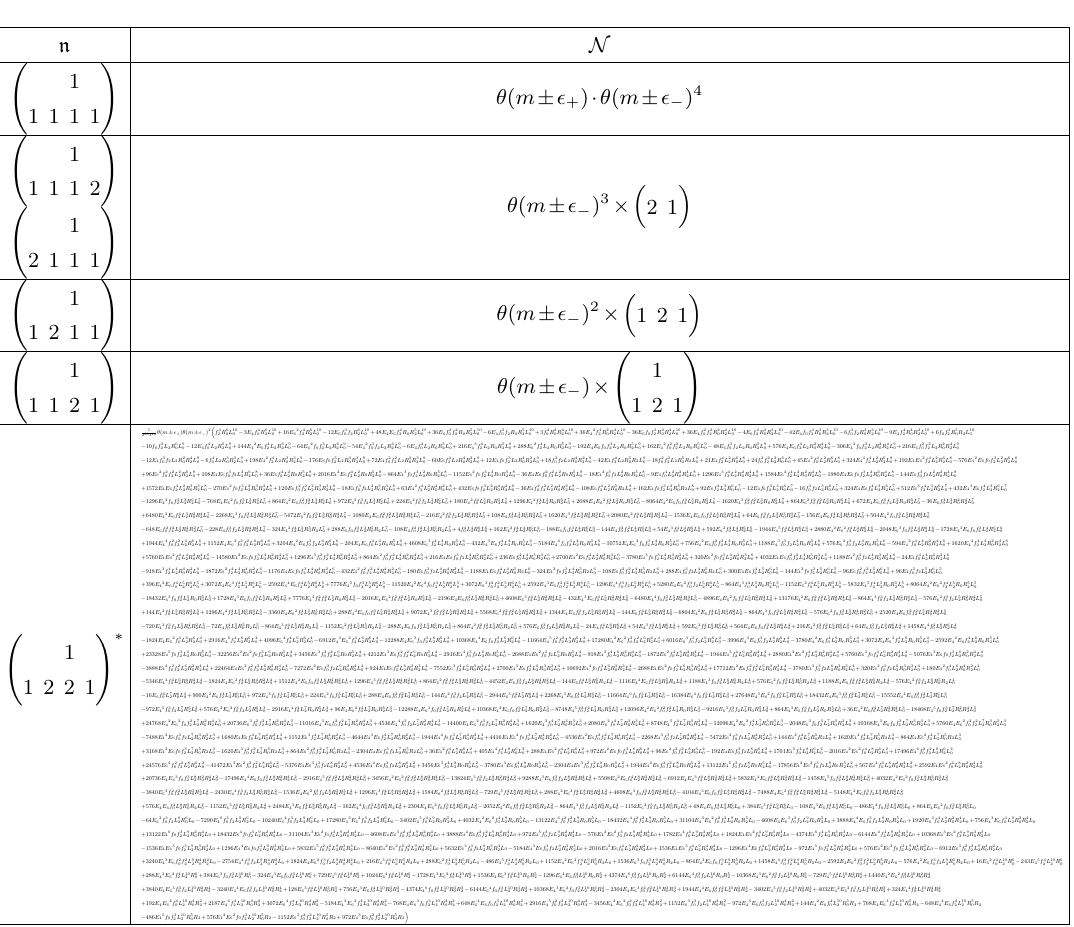
Table 5 . Elliptic genera of D 5 . The result that cannot be obtained from the flip symmetry is marked with the